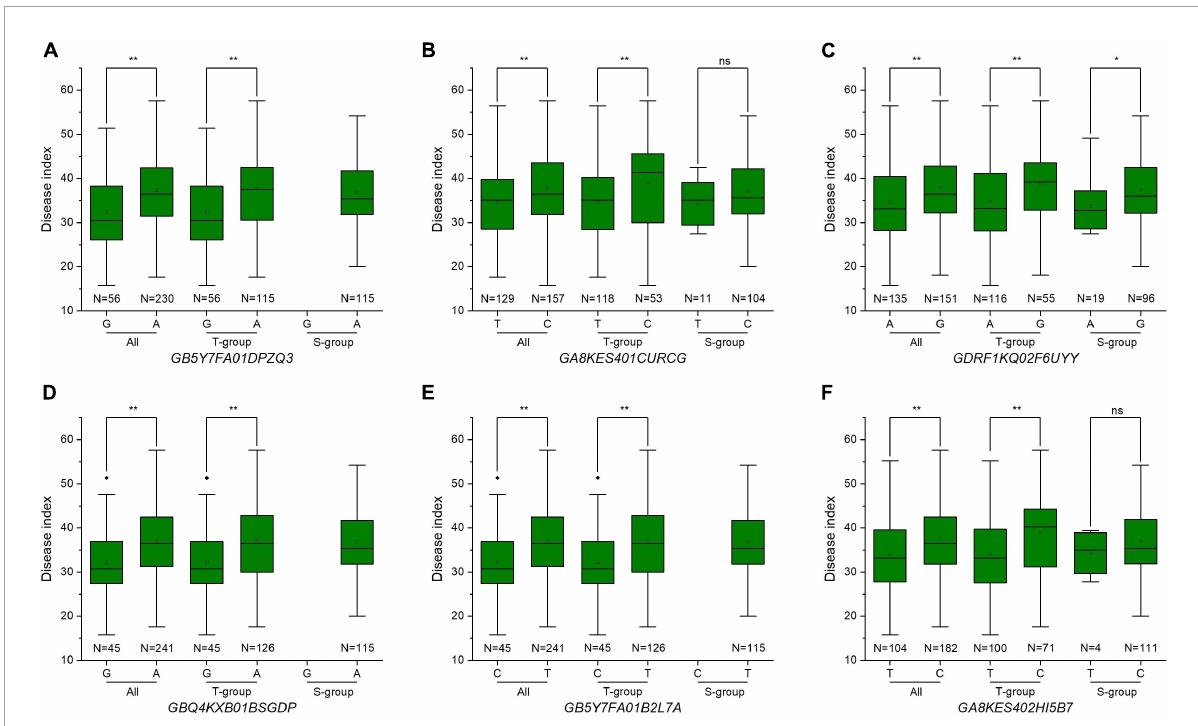
FIGURE4 Allele distributions of significant single nucleotide polymorphisms (SNPs) significantly associated with Fusarium crown rot resistance. (A–F) Allele distributions of the six significantly associated SNPs GB5Y7FA01DPZQ3 , GA8KES401CURCG , GDRF1KQ02F6UYY , GBQ4KXB01BSGDP , GB5Y7FA01B2L7A , and GA8KES402HI5B7 among the whole population and subgroups. S-group and T-group represent the Aegilops tauschii ssp. strangulata group and the Aegilops tauschii ssp. tauschii group, respectively. N represents the number of